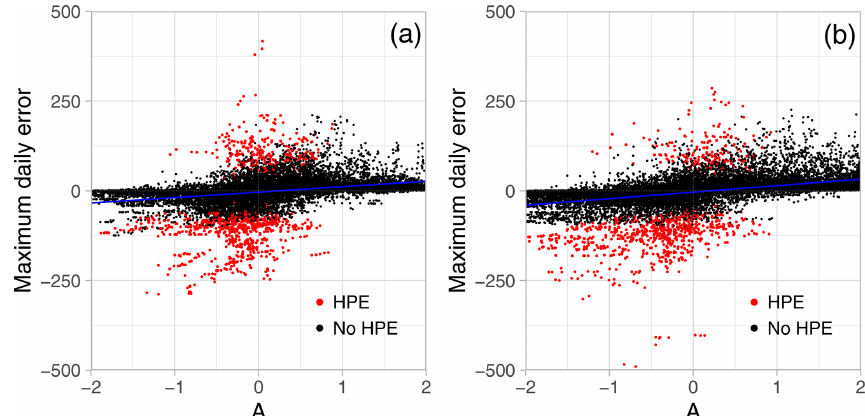
Figure 5. Relationship between the daily rainfall grid-point maximum algebraic error and the A component of the SAL score. HPE days are plotted in red, while other days are in black. Panel (a) is for LT12 lead time, and (b) shows LT34 lead time. Linear regression analysis is added to the plot.